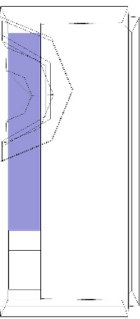
Figure 2. Imported CAD of the transducer viewed from top. Due to symmetry along the longitudinal axis only half the transducer is shown. Backing mass is in mechanical and electrical contact with the piezoelectric element. The actuation area on the top electrode of the piezoelectric element is highlighted in blue (it doesn’t extend to the full length of the transducer due to the wrapped around electrode, configuration A). The access cable is cleared from internal electrical connection.